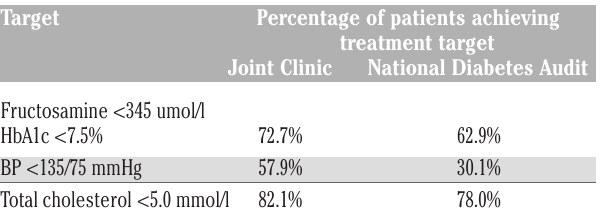
Table 3. Rate of achievement of treatment targets in Joint Clinic compared to National Diabetes Audit for England (2007-2008). Target